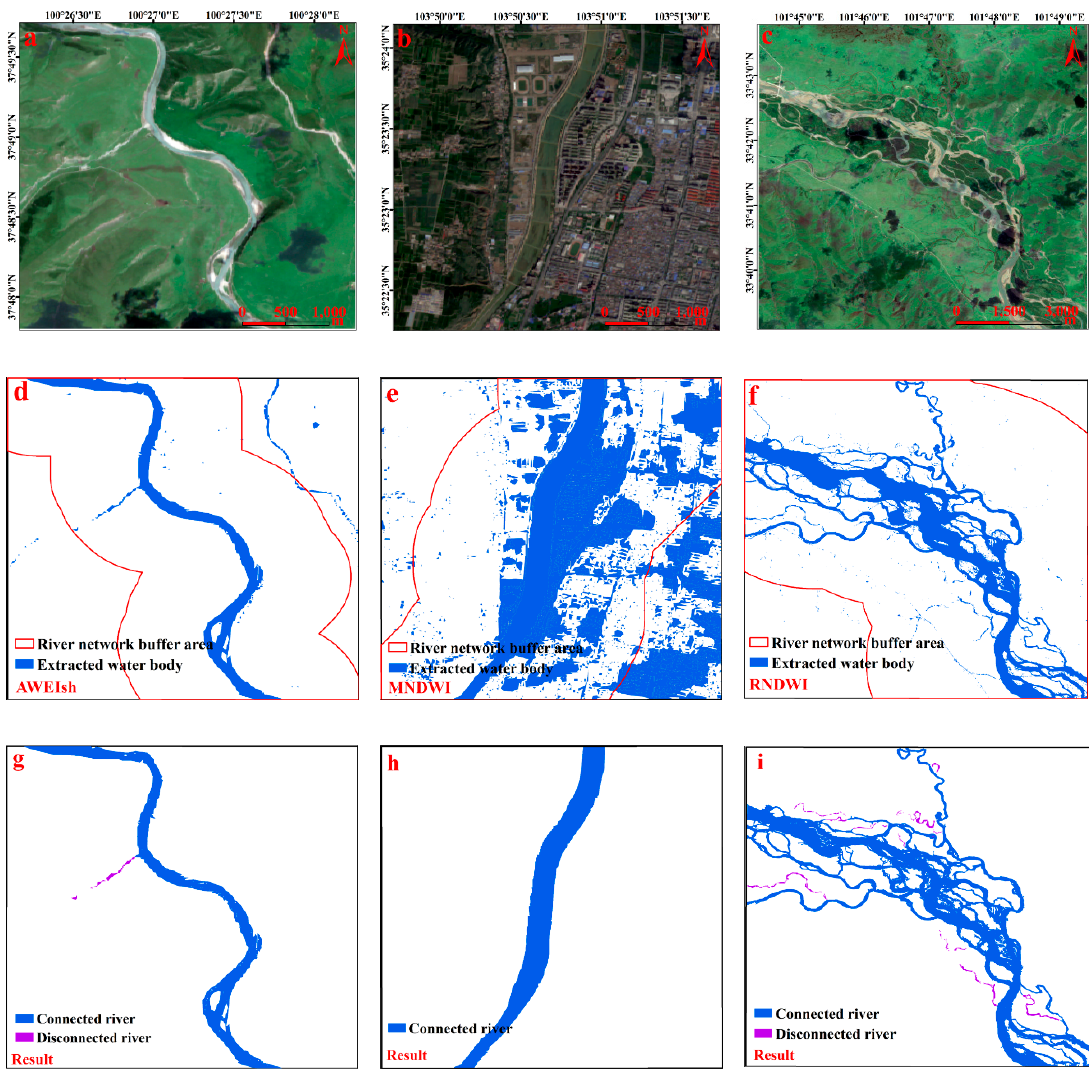
Figure 4. Step-wise data processing results. ( a – c ) are the original red, green, and blue (RGB) images. ( d – f ) are the extracted water bodies based on AWEI , MNDWI , and RNDWI ; the area surrounded by red lines is the river network bu ff er zone. ( g – i ) are the final extraction results of rivers, the blue line is connected river, and the purple line is disconnected river.